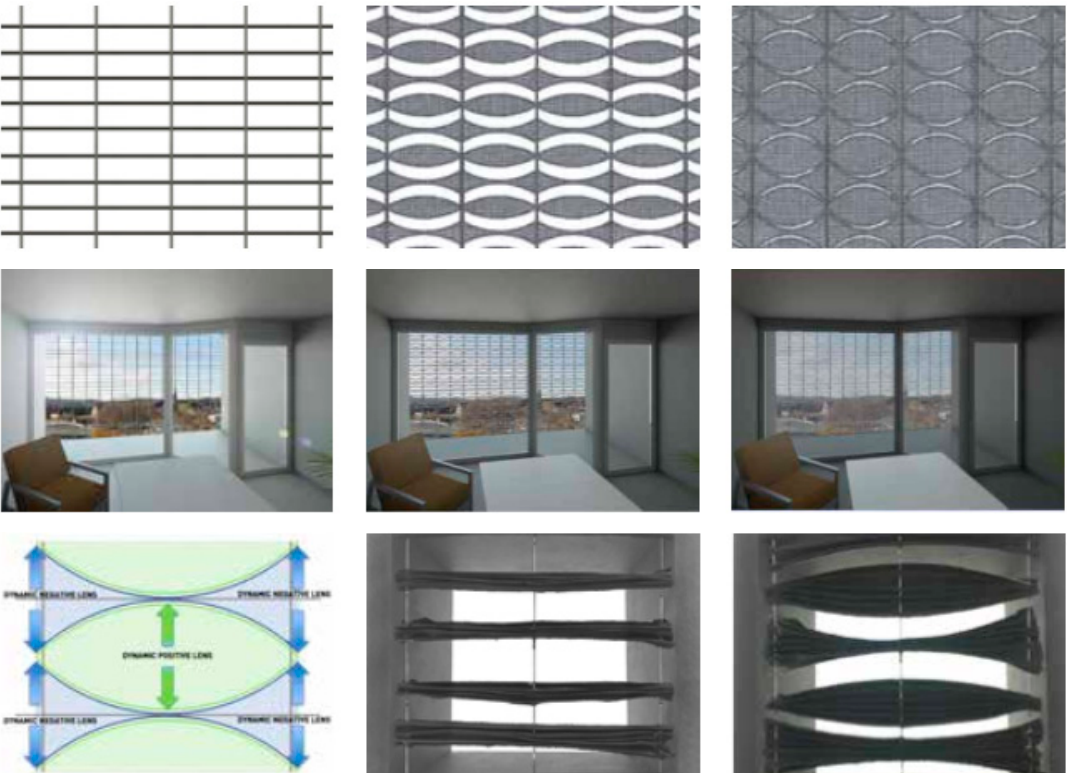
Figure 11. Prototypes of adaptive textiles composed of fabrics and bimetal strips (reproduced from [72] under the terms and condition of CC BY license).